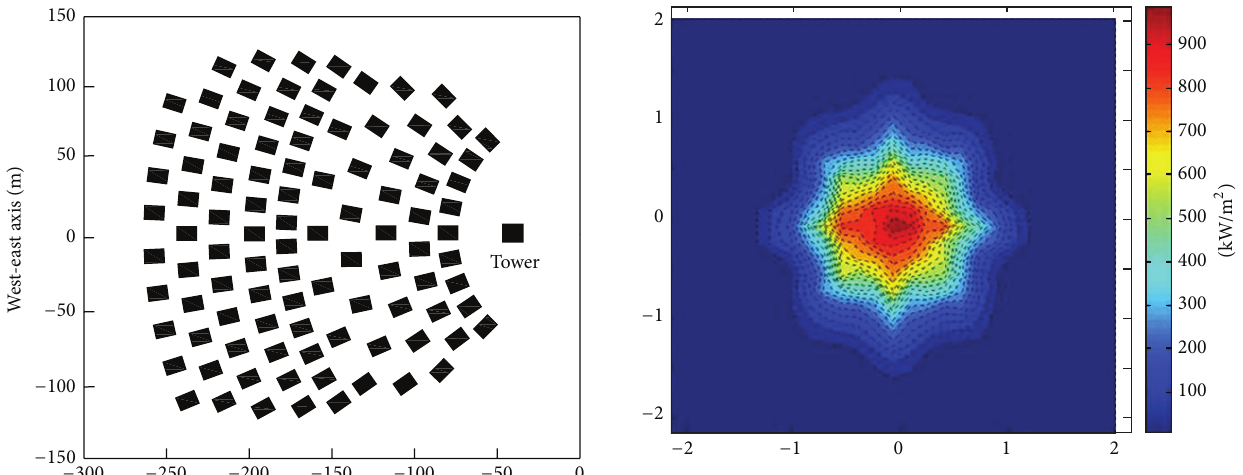
Figure 4: Distribution of solar flux in the aperture.